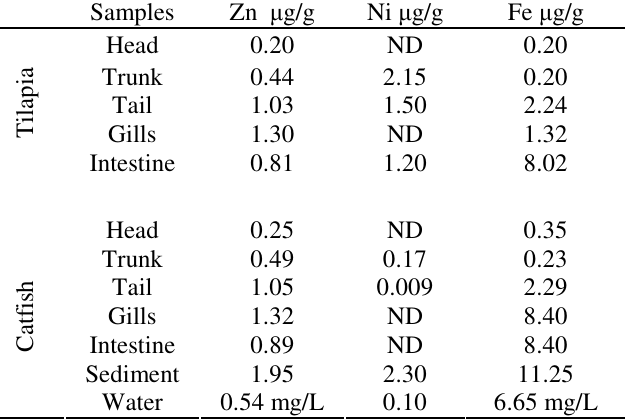
Table 2. Metal distribution in Badagry Lagoon